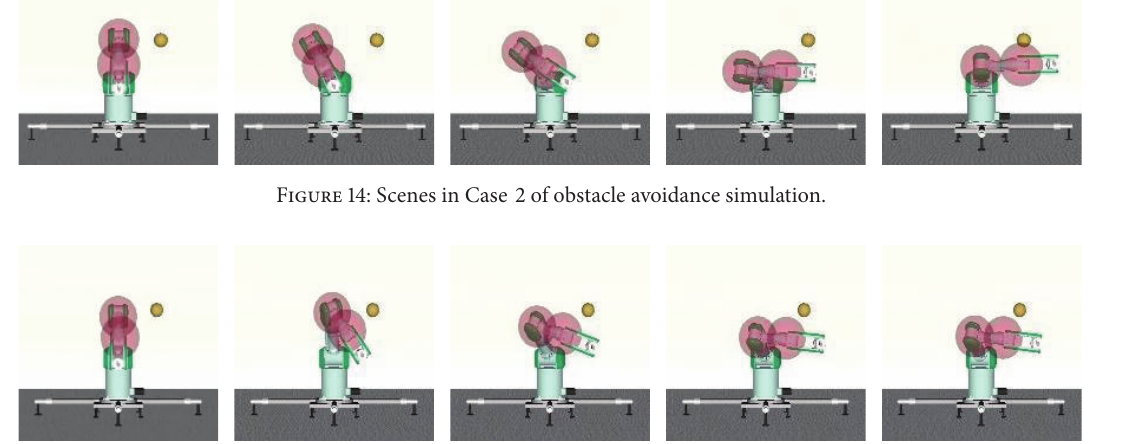
Figure 15: Scenes in Case 3 of obstacle avoidance simulation.